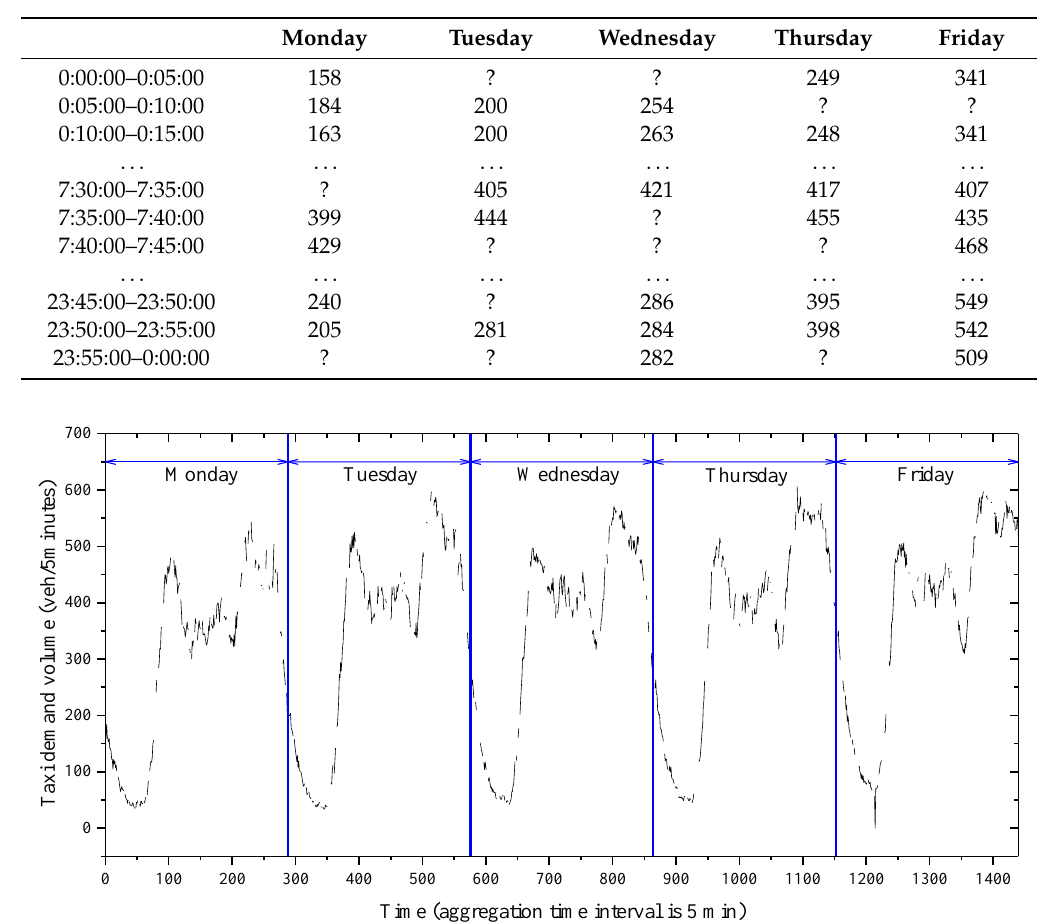
Figure 3. Incomplete data on weekdays based on a 5 min aggregation interval.